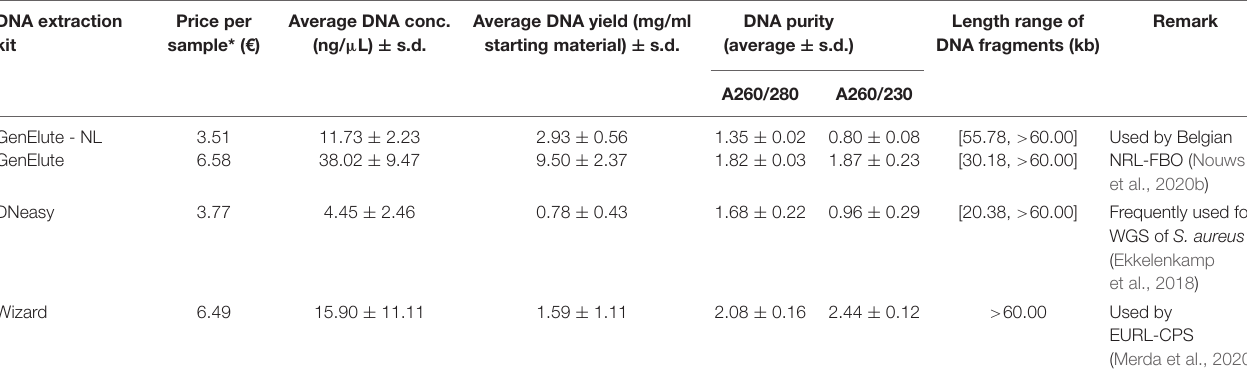
TABLE 2 | Characteristics of selected DNA extraction kits. DNA extraction kit